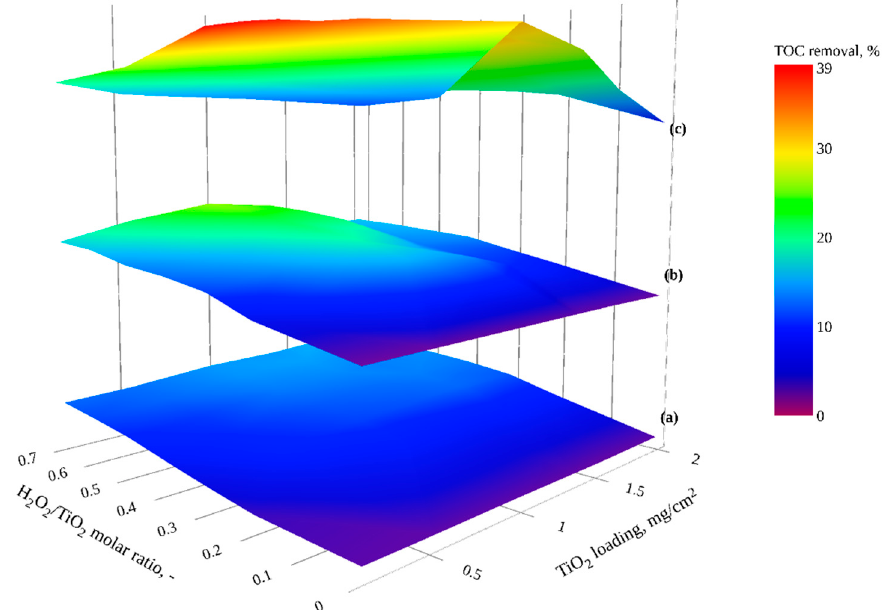
Figure 6. TOC reduction by H 2 O 2 / TiO 2 ( a ) in dark conditions ( b ) with visible light, and ( c ) with UVA irradiation as a function of H 2 O 2 / TiO 2 molar ratio and TiO 2 loading (interactive plots presented in Figures S6–S8).